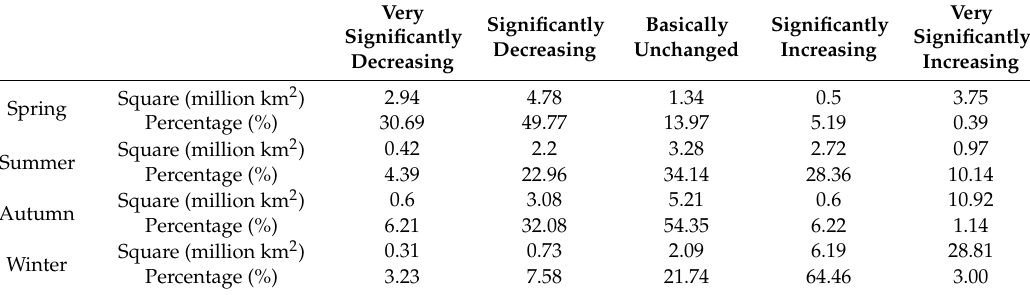
Figure 12. Spatiotemporal variations in seasonal average LST from 2003 to 2018. Table 5. Statistics of seasonal average LST of different variation levels.